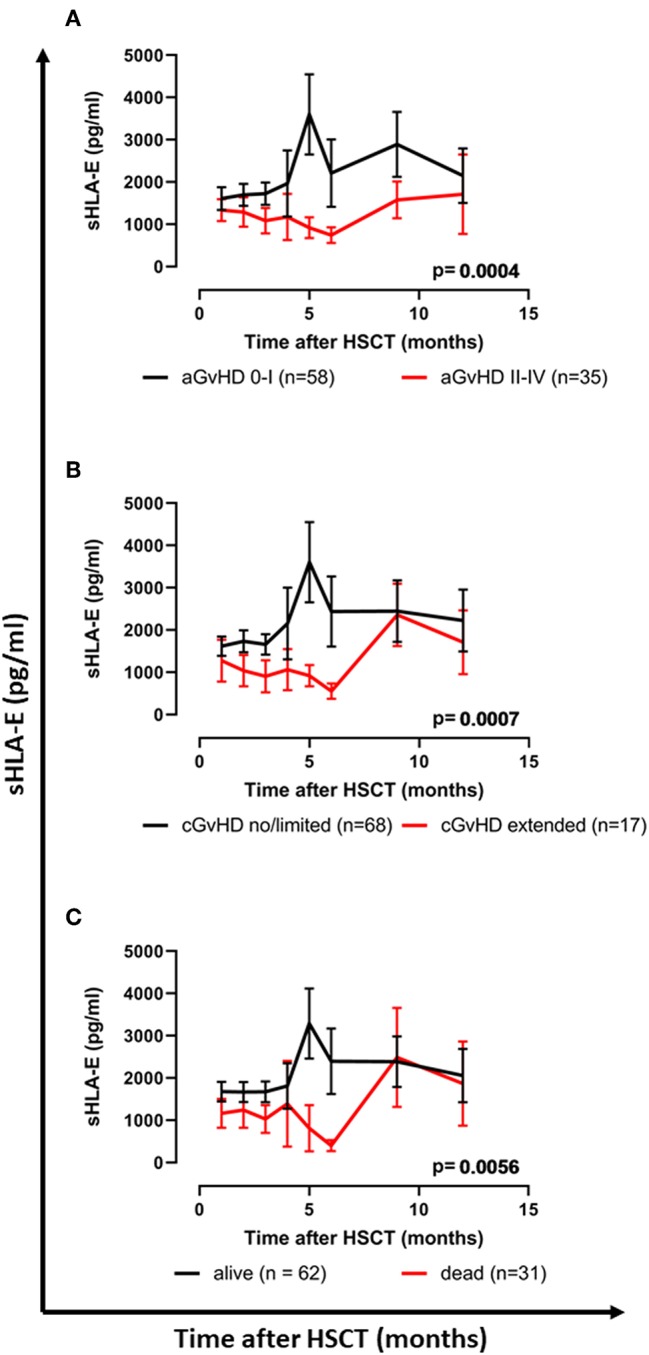
Association of reduced sHLA-E levels with severe acute, extended chronic GvHD, and inferior OS following HSCT. (A) The courses of sHLA-E levels in patients with (A) aGvHD grade II–IV (red line) vs. aGvHD grade 0–I (black line), (B) extended cGvHD (red line) vs. no/limited cGvHD (black line), or (C) patients having died (red line) vs. patients being alive (black line) during the follow-up time. Data are presented as mean ± SEM. Manifestation of aGvHD or cGvHD could not be evaluated for all patients due to death or missing clinical data.